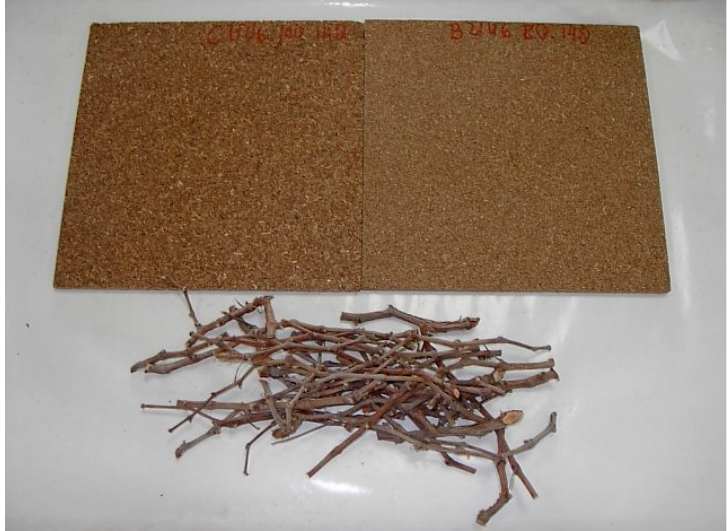
Figure 1. Vine prunings and samples of the manufactured boards (300 × 300 mm 2 ).